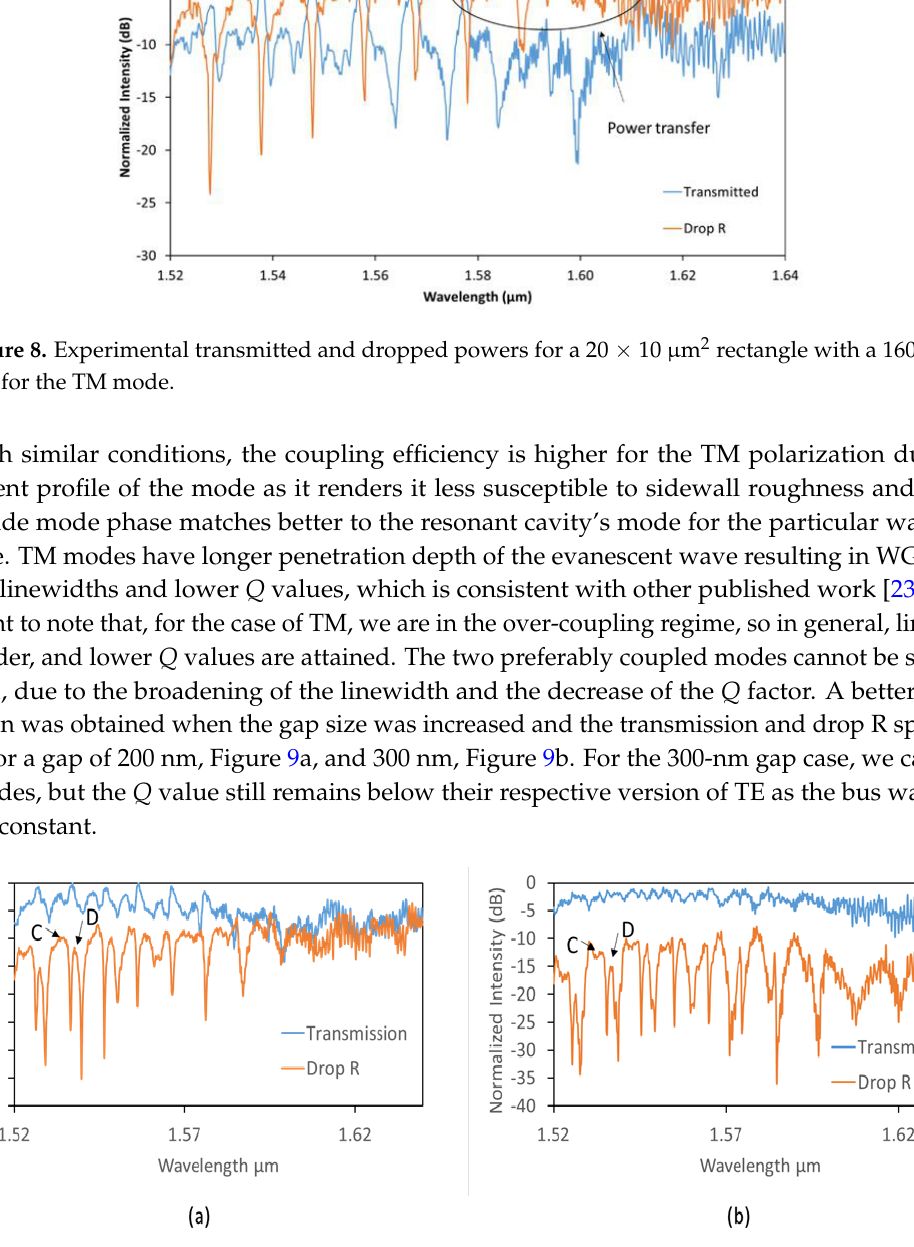
Table 1. Optimum parameters to obtain the highest Q value.